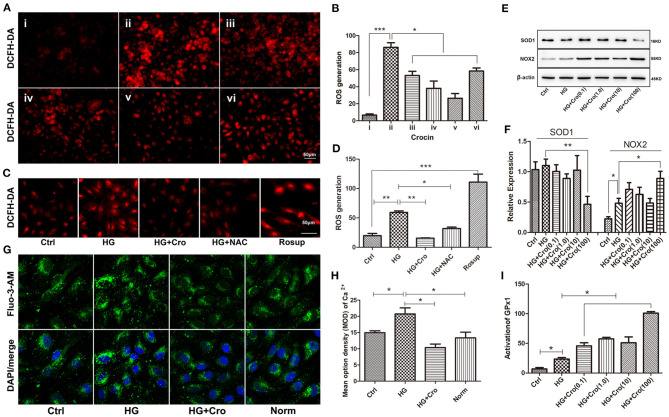
Effect of crocin on ROS production, SOD1, NOX2, and GPx1 in HG-cultured endothelial cells. (A,B) ROS fluorescent probe DCFH-DA revealed that HG induced excessive ROS production, whereas crocin significantly counteracted this increase in the dose range of 1–10 μmol/L. i: control (mannitol 33 mmol/L), ii–vi: HG (33 mmol/L) + crocin (0, 0.1, 1, 10, and 100 μmol/L). (C,D) Both crocin (10 μmol/L) and NAC (10 μmol/L) reduced the HG-induced increase of ROS in HUVECs. Rosup (125 μg/ml) was used as a positive control to generate excessive ROS in this experiment. (E,F) Western blotting showed that HG has an enhanced effect on NOX2 expression rather than SOD1. Crocin (0.1–10 μmol/L) did not alter the expression of NOX2 and SOD1 in HG-cultured endothelial cells; however, crocin at 100 μmol/L reduced SOD1 expression and enhanced NOX2 expression, respectively. (G,H) The confocal microscope showed that HG elevated intracellular Ca2+ probed by Fluo-3 AM compared to the control and normal groups, but crocin (10 μmol/L) reversed the increased intracellular Ca2+ concentration that is close to normal levels. (I) GPx activity assay revealed that HG increased GPx1 activation compared to the control group, and GPx1 is also promoted by crocin in the gradient dose (0.1, 1, 10, and 100 μmol/L). Ctrl, control (mannitol 33 mmol/L); HG, high glucose; Cro, crocin; NAC, N-acetyl-L-cysteine; Norm, normal glucose level; HUVECs, human umbilical vein endothelial cells; ROS, reactive oxygen species; SOD1, superoxide dismutase 1; NOX2, NADPH oxidase 2; GPx1, glutathione peroxidase 1. Results are presented as means ± SEM of at least three independent experiments. *p < 0.05, **p < 0.01, ***
p < 0.001. One-way ANOVA followed by Tukey's multiple comparisons test.